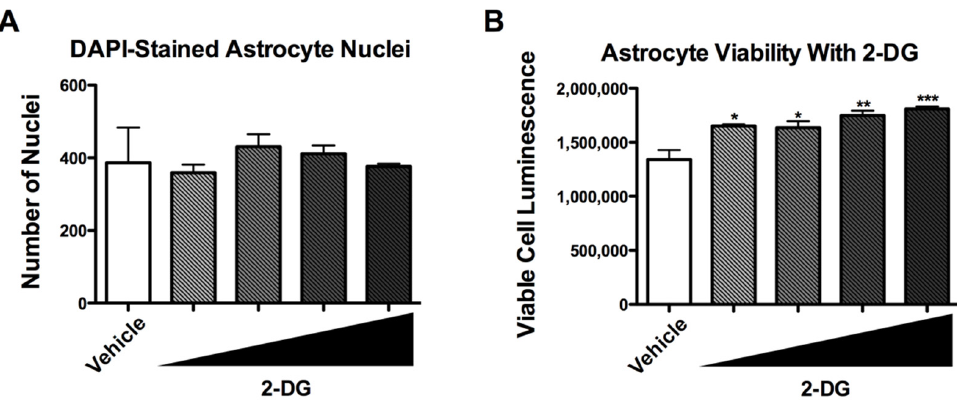
Figure 4. 2 ‐ DG does not contribute to cell death in astrocytes . ( A ) Fluorescence imaging and quantification of nuclei present in astrocyte cultures treated with increasing concentrations of 2-DG (1, 5, 10, and 20 mM). ( B ) Viable cell luminescence values of astrocytes treated with increasing doses of 2 ‐ DG (1, 5, 10, and 20 mM). One ‐ way ANOVA was performed to the determine effect of 2 ‐ DG treatment on astrocyte viability [F (9, 10) = 11.72, p < 0.001]. A post hoc Tukey’s test was conducted with corrected p ‐ values shown (* p < 0.05; ** p < 0.01; *** p < 0.001 vs. vehicle).